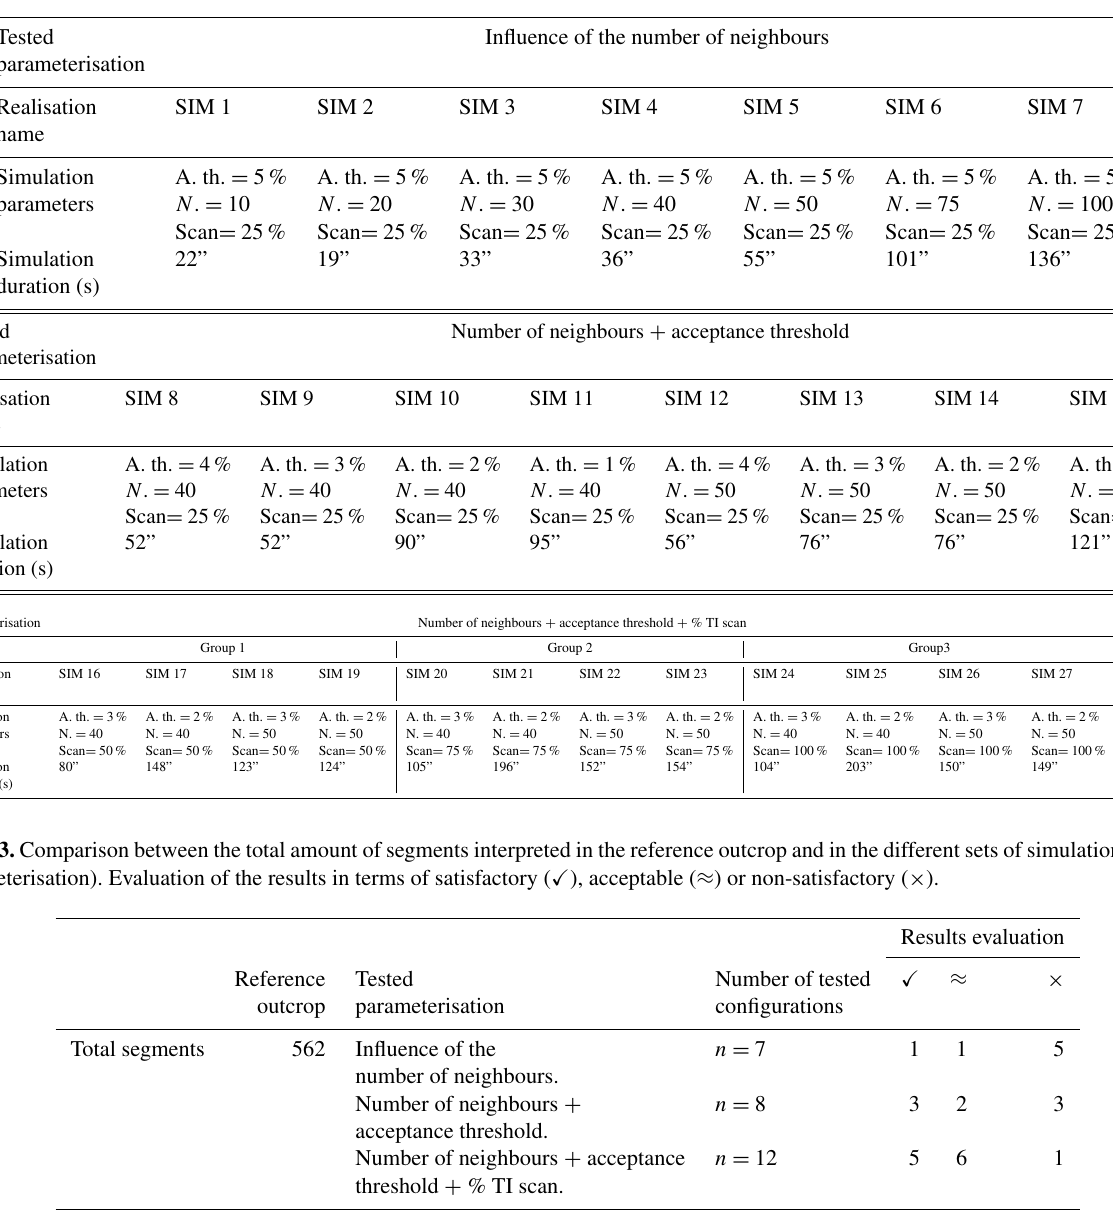
Table 2. Simulation parameterisation, model set-ups and duration (in seconds) of each run. In the table A. th. stands for acceptance threshold, N stands for number of neighbours and “Scan” denotes the scanned fraction of the training image.